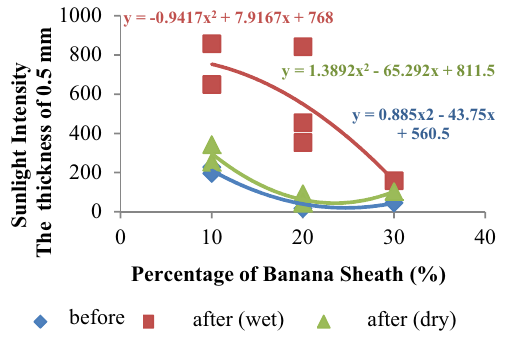
Fig. 4 The correlation between sunlight intensity and the percentage of water hyacinth in 0.5 mm organic mulch sheet